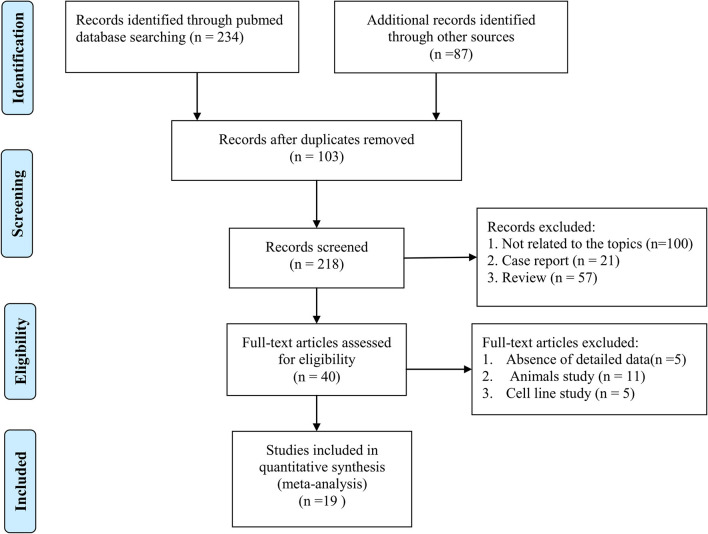
Flowchart diagram of selecting studies process.